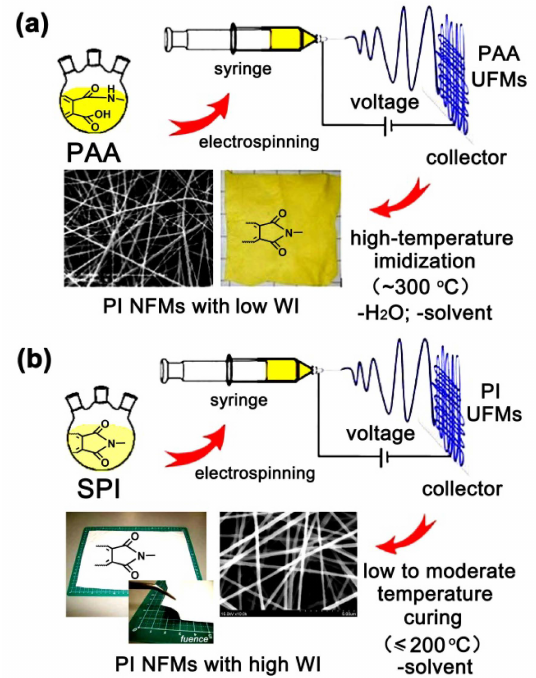
Figure 1. Effects of electrospun medium on the whiteness of PI UFMs. ( a ) PAA medium; ( b ) SPI